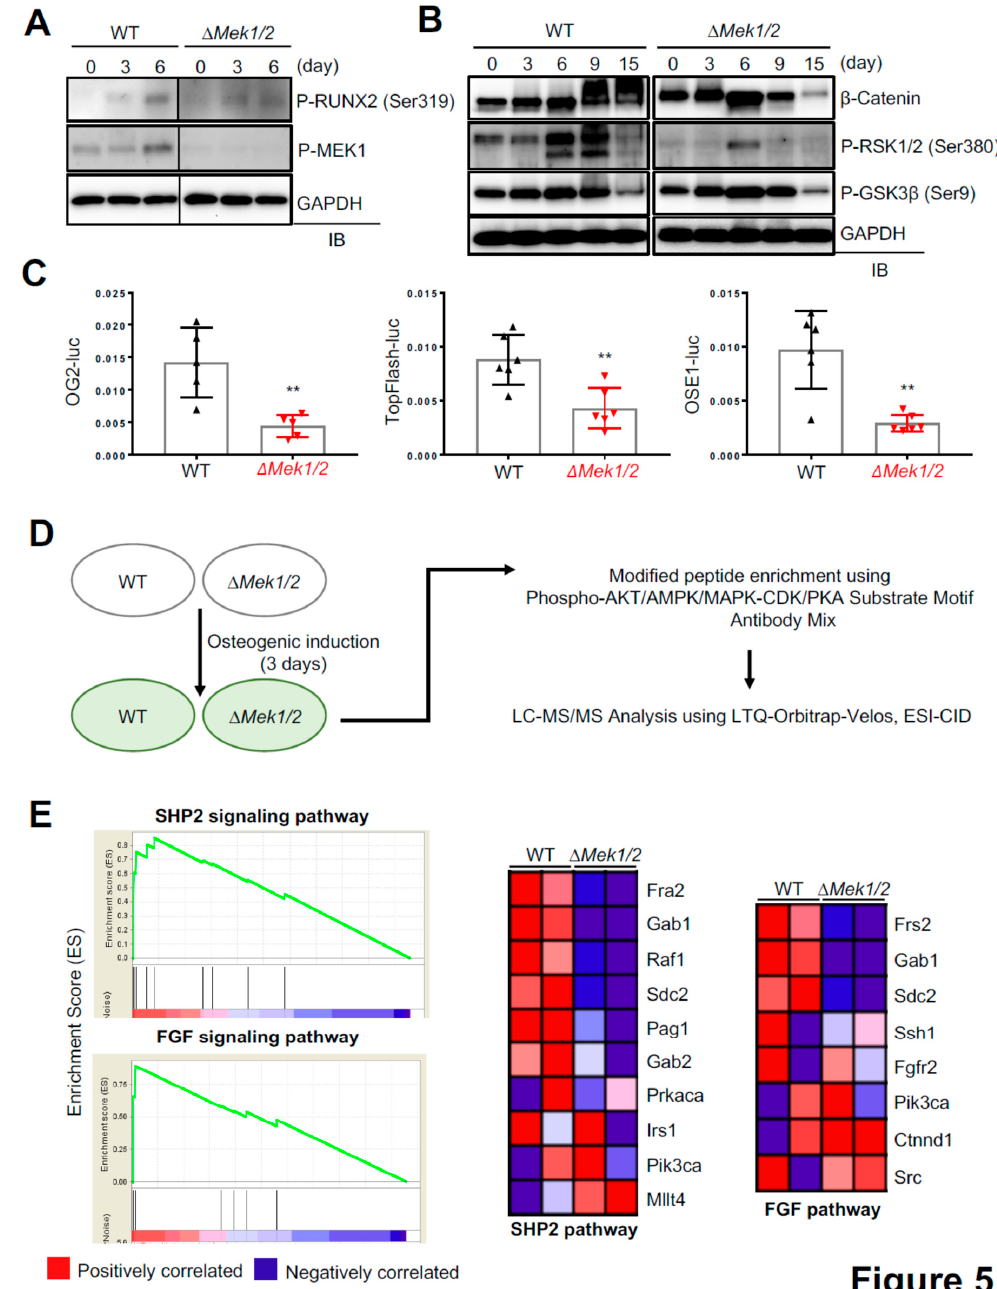
Figure 5. The MEK ‐ ERK pathway is important for activation of osteoblast master regulators. ( A,B ) Primary WT and ∆ Mek1/2 COBs were cultured under osteogenic conditions and lysed at different time points. Phosphorylation levels of RUNX2 (Ser319) and MEK1 (A) and GSK3 β (Ser9) and RSK1/2 (Ser380) (B) and protein levels of β‐ catenin (B) were assessed by immunoblotting with the indicated antibodies. ( C ) Primary WT and ∆ Mek1/2 COBs were transfected with OG2 ‐ luc (RUNX2), TopFlash ‐ luc (Wnt/ β‐ catenin), or OSE1 ‐ luc (ATF4) reporter genes along with Renilla . Twenty four hours after transfection, luciferase activity was measured and normalized to Renilla. ( D ) Experimental strategy to identify proteins differentially phosphorylated in WT and ∆ Mek1/2 COBs. ( E ) Enrichment plots (left) and gene signature sets (right) in WT and ∆ Mek1/2 COBs. Gene ‐ set enrichment analysis (GSEA) analysis displays enrichment of genes involved in SHP2 and the FGF signaling pathway. Values represent mean ± SD.; ** p < 0.01 by an unpaired two-tailed Student’s t -test